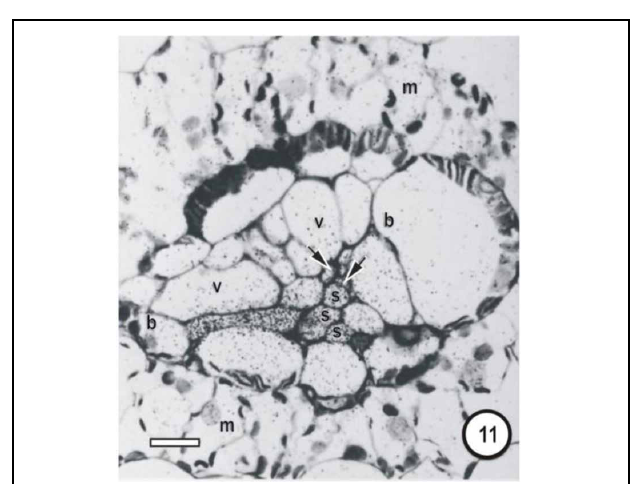
FIGURE 11 | Microautoradiographs of small vascular bundles in a Zea mays leaf and portions of transverse veins after 5min feeding with 14 CO 2 , followed by a 10-min 12 CO 2 chase showing accumulation of the 14 C label in thick- and thin-walled sieve tubes. The sieve tube of transverse vein enters the bundle at the level of the thin-walled sieve tubes (STs). Label has accumulated in STs and has been exported to a transverse vein ST. b, bundle-sheath cell; m, mesophyll cell; s, thin-walled sieve tube; v, vessel; unlabeled arrows point to thick-walled sieve tubes; bars = 16 µ m. Adapted and used with permission of the publishers (Springer; License No 2795360987331) from Fritz et al. (1983). Labeling as in original paper and for details, see Fritz et al.